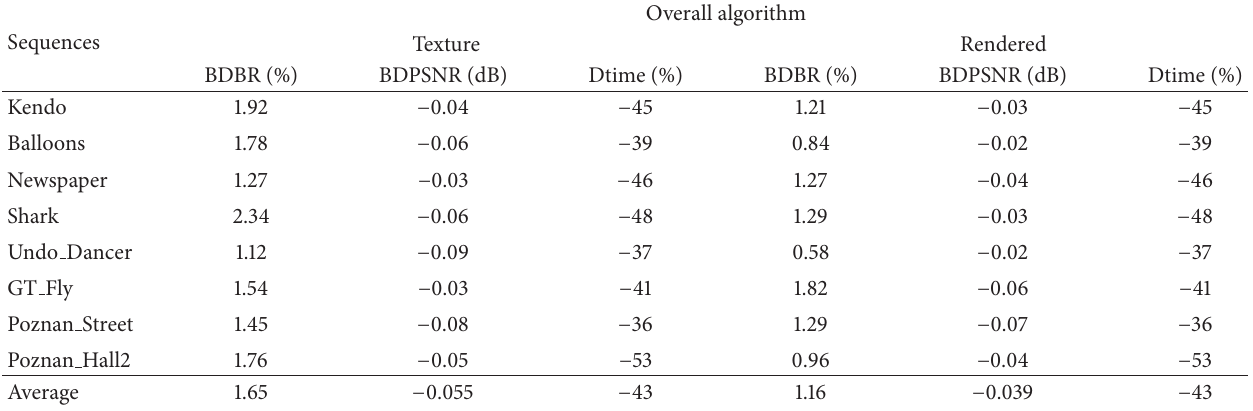
Table 5: Results of the proposed overall algorithm compared with